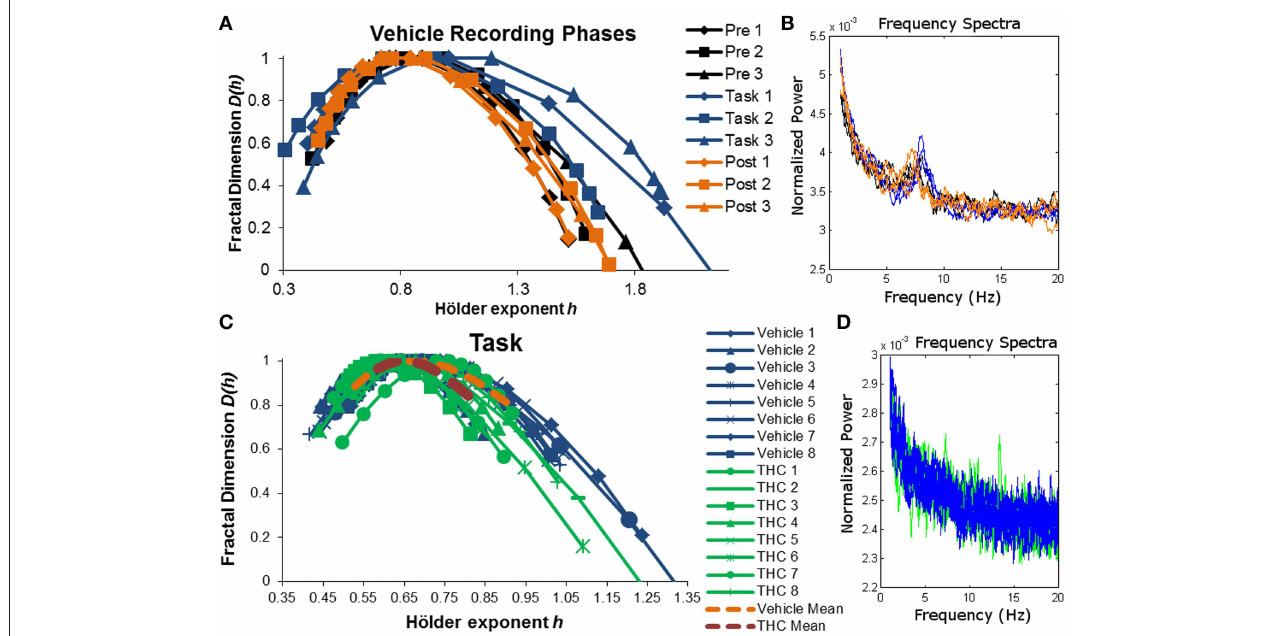
FIGURE 4 | Singularity and frequency spectra of example neurons. Singularity and frequency spectra pairs are shown for two different CA1 neurons. Single neurons were measured across multiple days in various recording phases (pre-task, task, post-task) and drug conditions (vehicle or THC) and each spectrum trace represents the multifractal complexity (A,C) and frequency content (B,D) computed from one recording phase on 1 day. (A) Singularity spectra are shown for each recording phase over three vehicle experiment days (diamonds for day 1, squares for day 2, triangles for day 3). Singularity spectra are wider, thus multifractal complexity is greater, during the task compared to either resting state recording phases. (B) Frequency spectra are shown for the same neuron recorded during the same 3 days as in (A) and color coded to match the legend in (A) . This neuron exhibits both delta (0.5–4Hz) and theta (4–8Hz) frequency activity during all recording phases on all days. (C) Singularity spectra computed from the DNMS task are compared between vehicle and THC conditions for one example neuron recorded over 16 total days. Individual session singularity spectra are plotted in thin blue lines for vehicle and green lines for THC sessions. The average singularity spectra for this neuron is plotted as a dashed orange line for vehicle and as a dashed red line for THC. (D) Frequency spectra are shown for the same neuron recorded during the same 16 days as in (C) and color coded to match the legend in (C) . Only spectra from individual neurons were plotted. This neuron exhibits delta rhythm